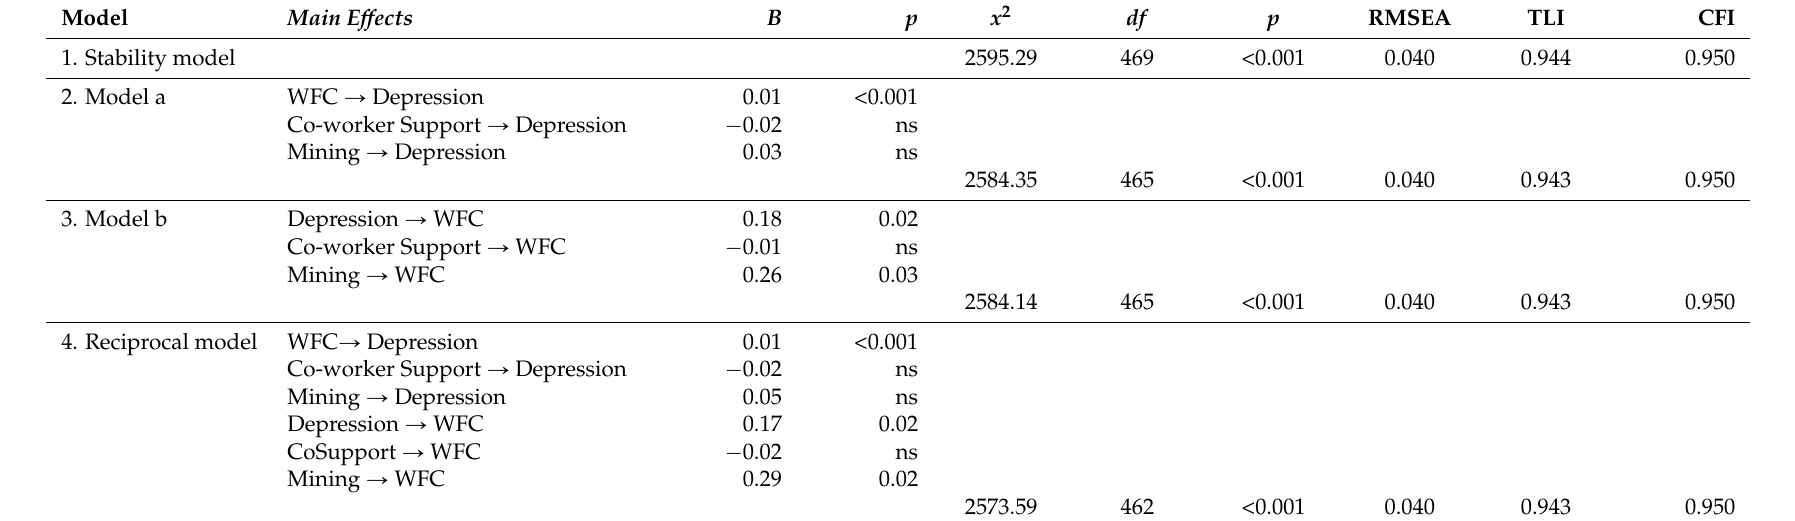
Table 3. Main effects and fit indices for study models over time for Australian